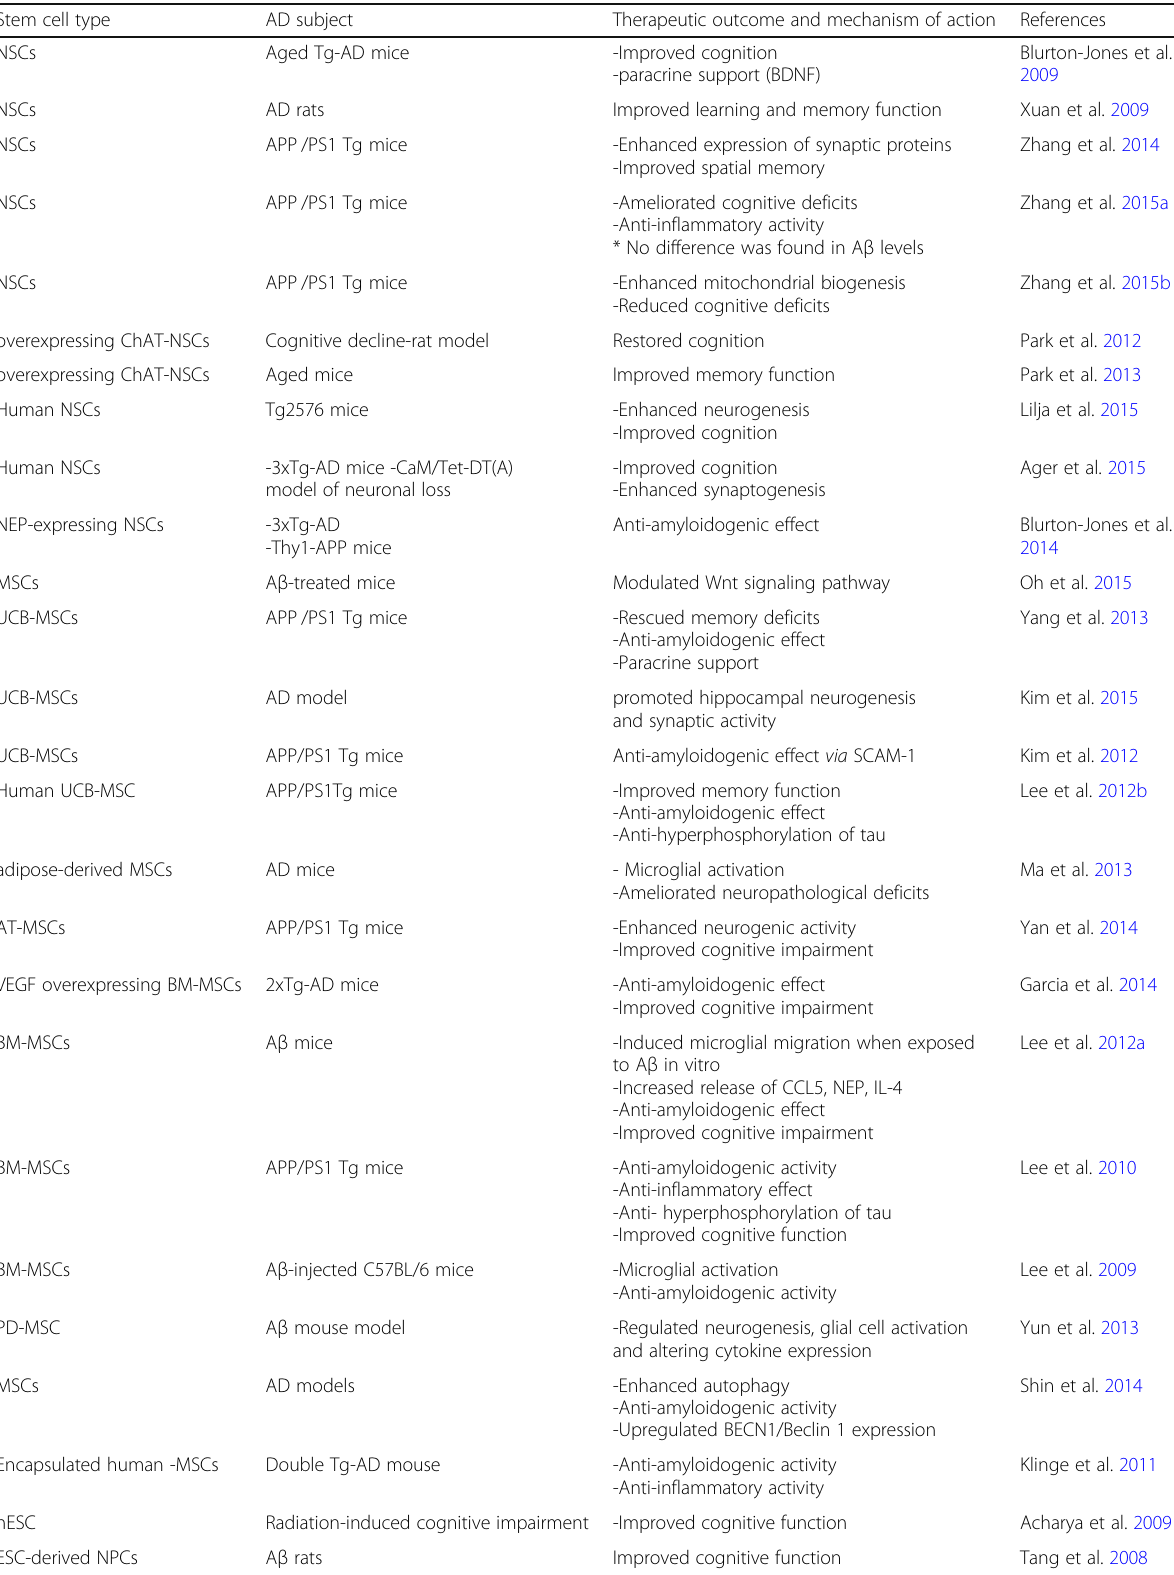
Table 1 Transplantation studies of stem cells in AD animal models Stem cell